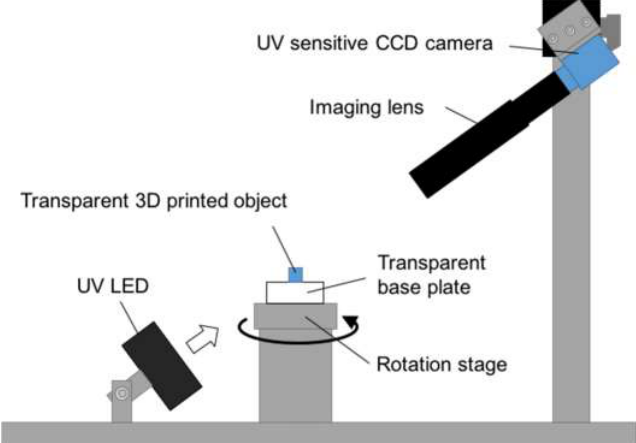
Figure 2. Optical setup for SFS using ultraviolet (UV) illumination. A silhouette image of the target object with UV illumination was captured by the UV sensitive charge‑coupled device camera. Multiple silhouette images with different viewpoints were obtained by rotating the rotation stage at 10° intervals.